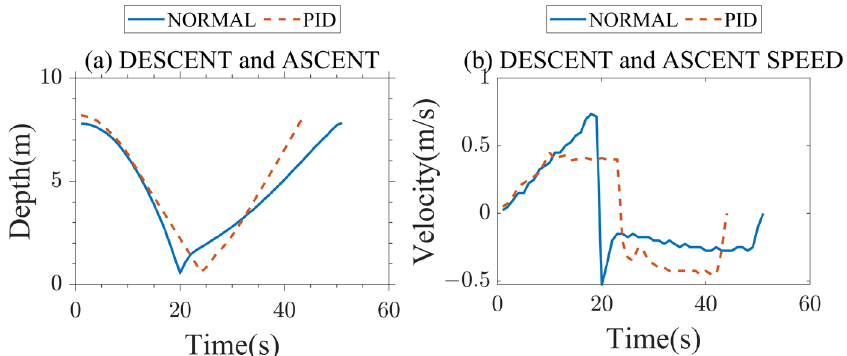
Figure 13. Comparison between NORMAL and PID for profile AUV descent and ascent.